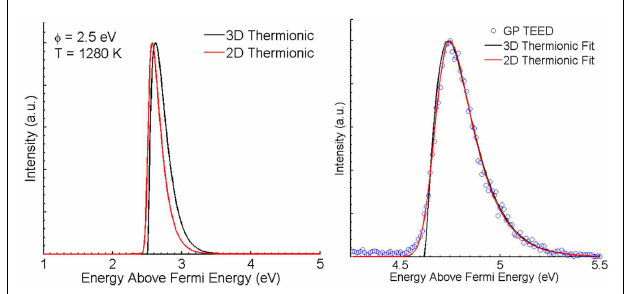
FIGURE 7 | Example three-dimensional and two-dimensionalTEEDs from theory (left) with φ = 2.5eV, T = 1280K, σ = 0.08eV, and from data fitting (right) to an experimentalTEED from graphitic petals at a temperature of 1123K .